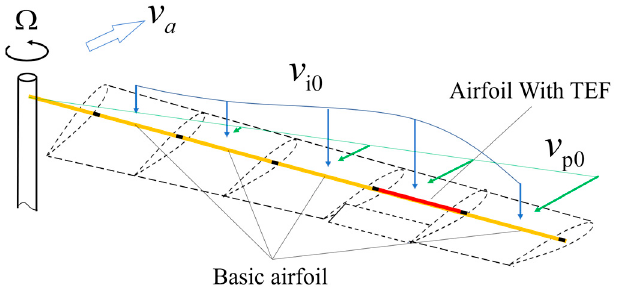
Figure 4. Schematic diagram of the aerodynamic model.